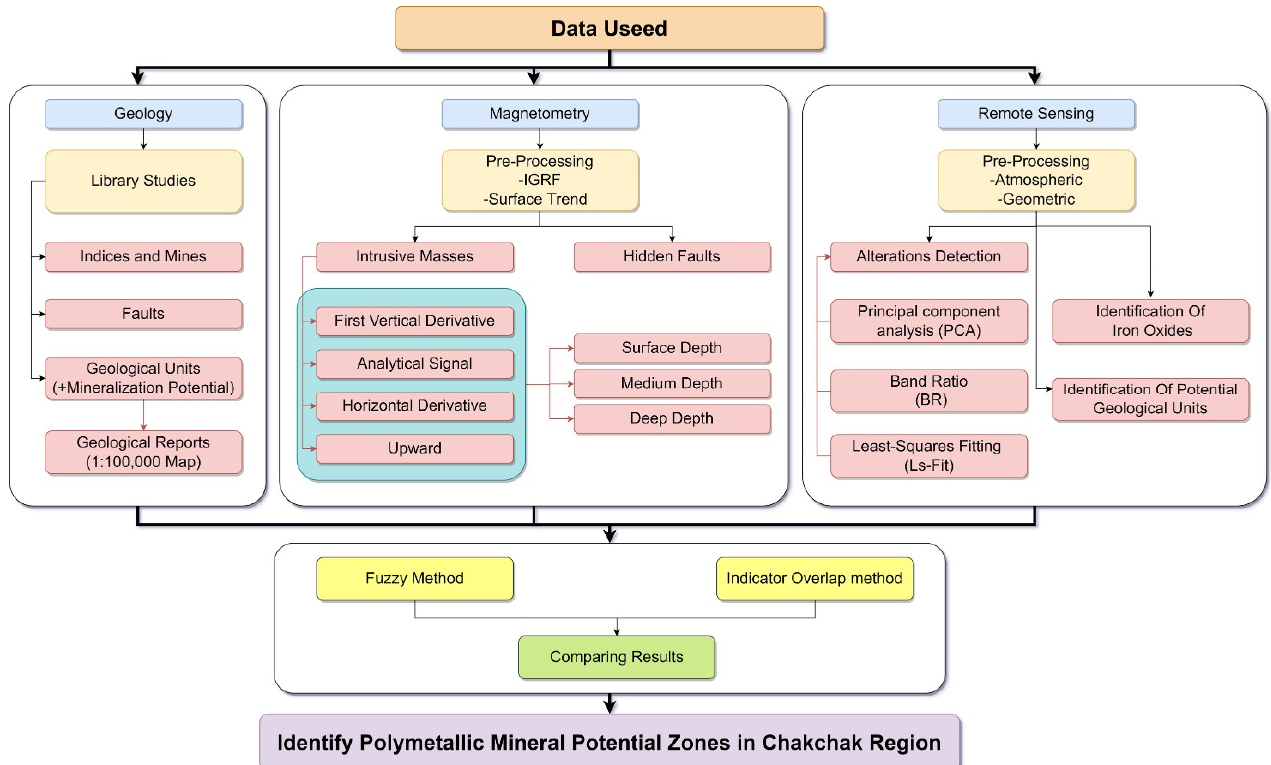
Figure 2. An overview of methodological flowchart used in this